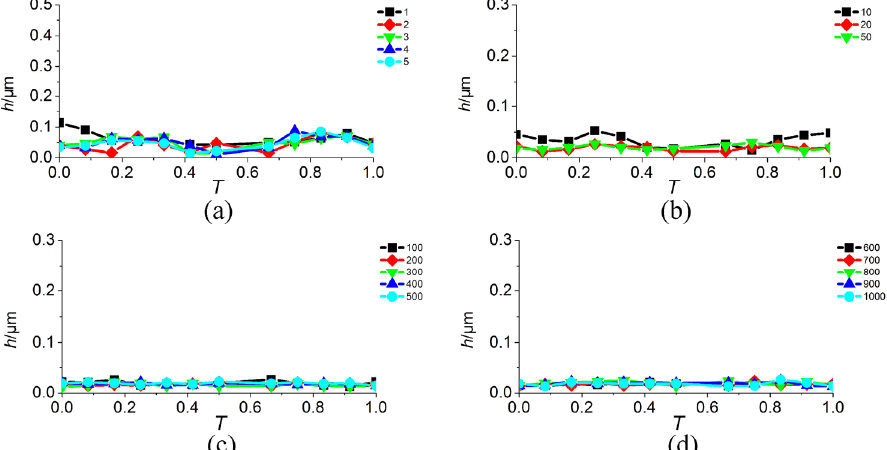
Fig. 15 Variation of minimum film thickness in some typical working periods ( v max = 0.01 m/s, w = 50 N, T = 0.5 s, L = 1.25